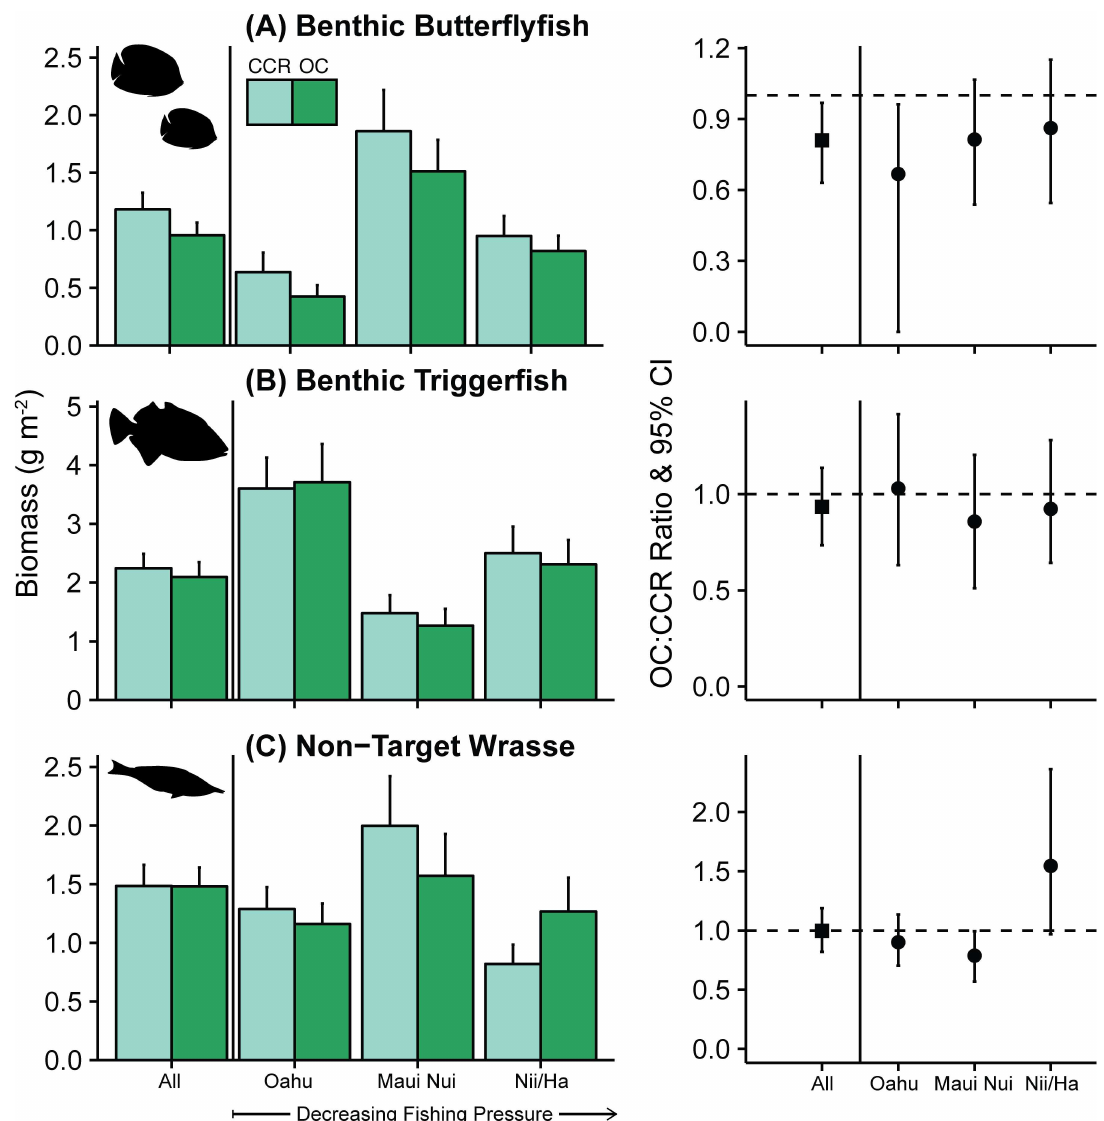
Fig 4. Biomass for non-target groups. Biomass boxplotwith error bars indicating standard error for all sites and for Oahu, Maui Nui and Nii-Hama(Niihauand Hamakua coast). Locationgroups are orderedin directionof presumeddeclining spearfishing pressure from Oahu (highest) to Niihau-Hamakua (lowest). OC:CCR biomass ratio has 95% confidenceinterval for each